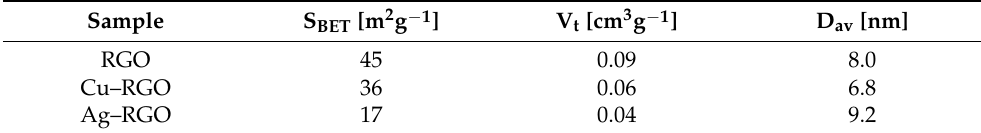
Figure 4. Nitrogen adsorption–desorption isotherms ( a ) and pore-size distributions ( b ). Table 1. Texture parameters—specific surface area, total pore volume, average pore diameter.